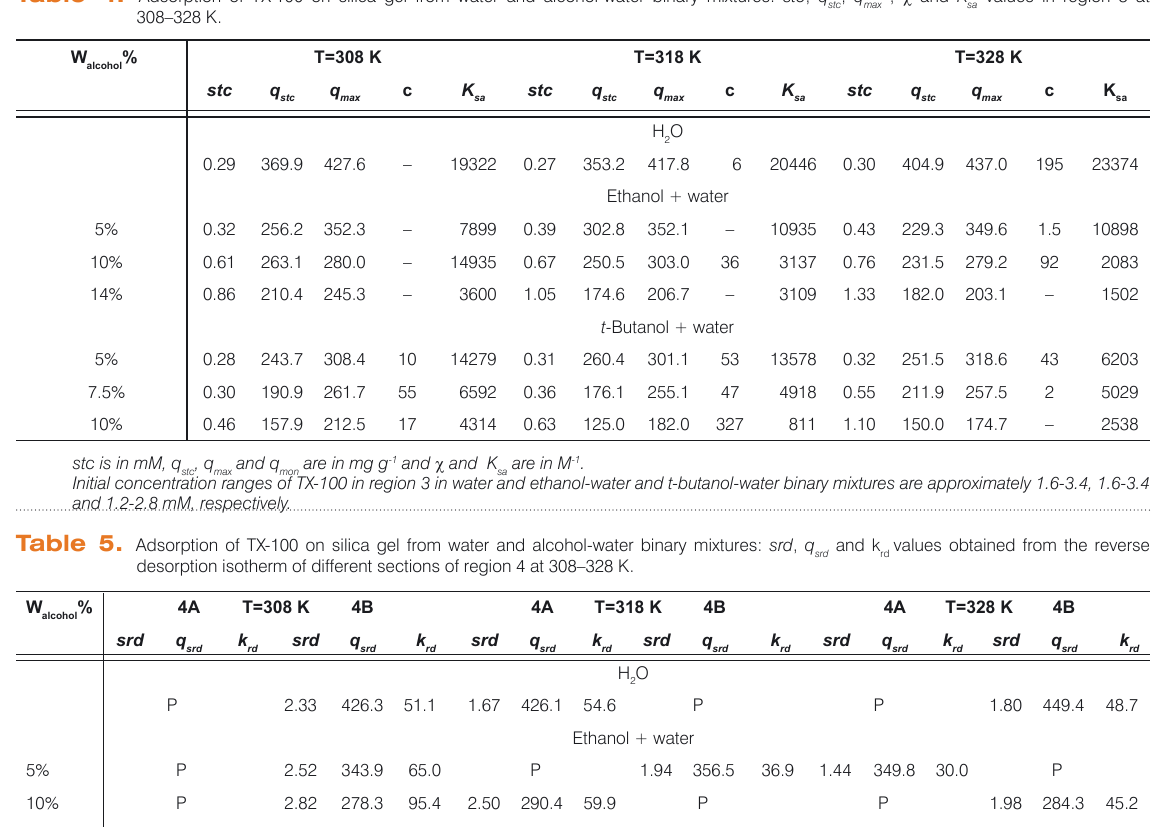
, q , c and K values in region 3 at stc max sa